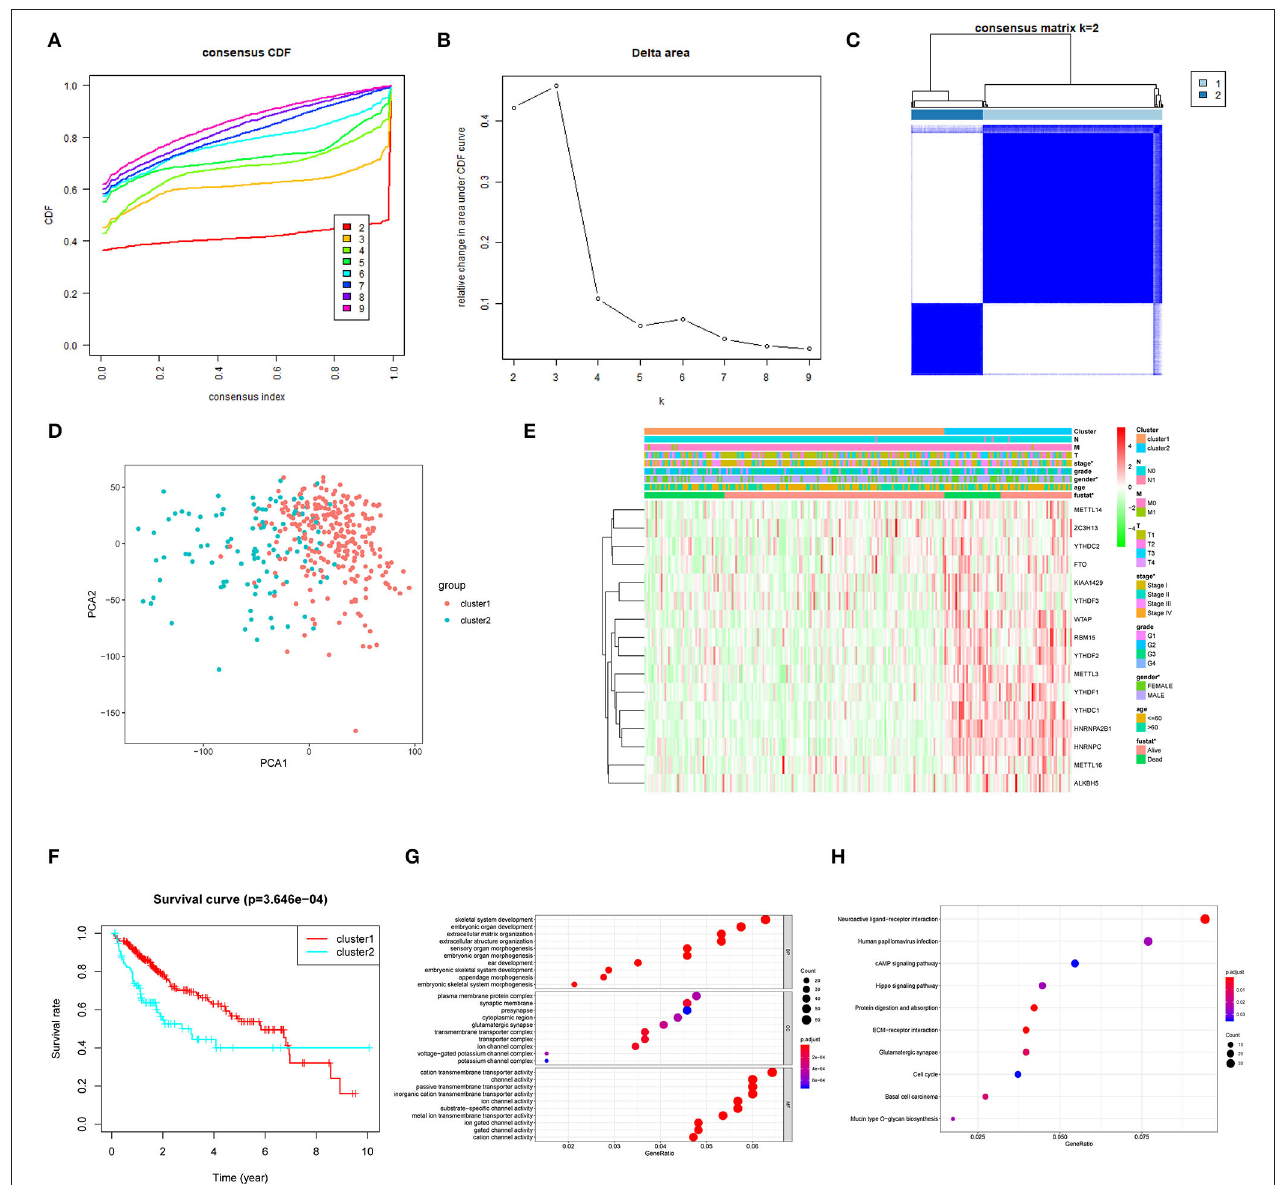
FIGURE 2 | Association between the N6-methyladenosine (m 6 A) RNA methylation regulators and clinicopathological and prognostic features of hepatocellular carcinoma (HCC) patients. (A) Consensus clustering model with cumulative distribution function (CDF) for k = 2–9. (B) Relative change in area under the CDF curve for k = 2–9. (C) The Cancer Genome Atlas (TCGA) liver hepatocellular carcinoma (LIHC) cohort was classified into two clusters with k = 2. (D) Principal component analysis of the total RNA expression profile of cluster 1 (red) and the cluster 2 (blue). (E) The correlation of the two clusters with clinicopathologic features was visualized by heatmap. (F) The overall survival of HCC patients in the two clusters was calculated by Kaplan–Meier curves. (G) Gene Ontology (GO) analyses were conducted to predict the potential function of the differentially expressing genes between the two clusters. (H) Kyoto Encyclopedia of Genes and Genomes (KEGG) analyses were performed to predict the underlying potential pathways regarding the differentially expressing genes. * P <